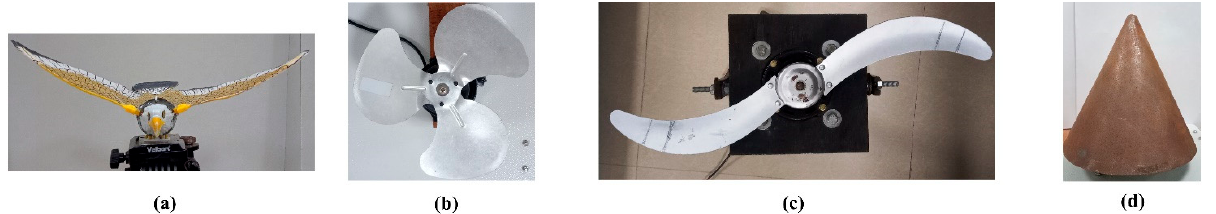
Figure 1. Low Radar cross − section (RCS) ( a ) flapping, ( b , c ) rotational, and ( d ) kinetic warhead motion targets used in work reported in this paper.